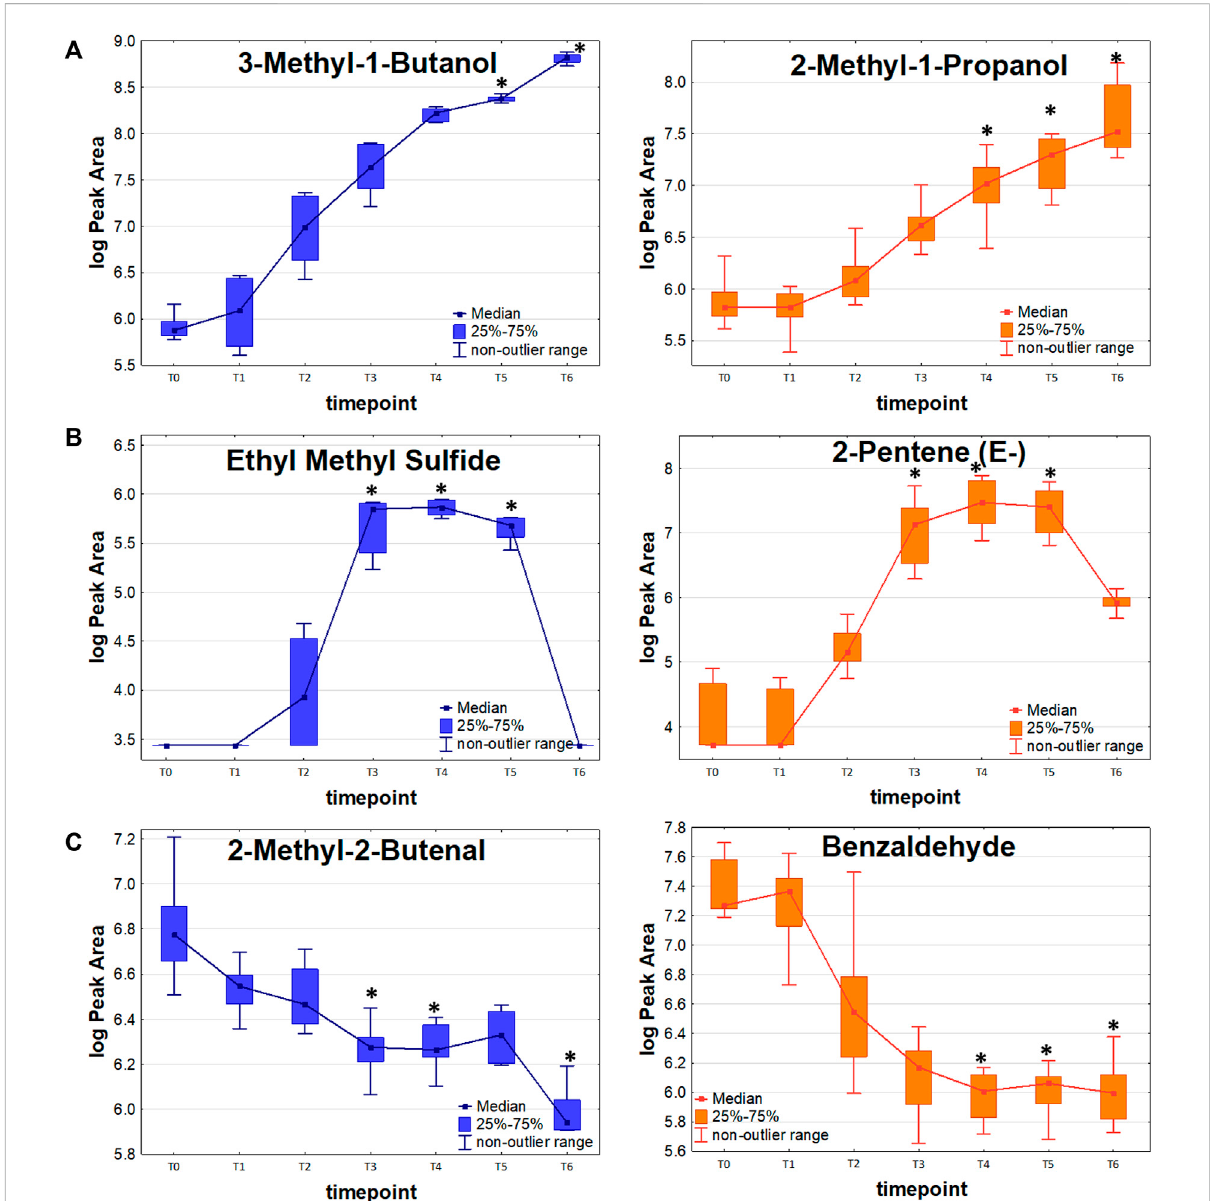
FIGURE 3 VOC release pro fi les in the function of bacteria proliferation. (A) : Release proportional to the bacteria load. (B) : Release with temporary maxiumum. (C) : Uptake of volatile metabolites by bacterial